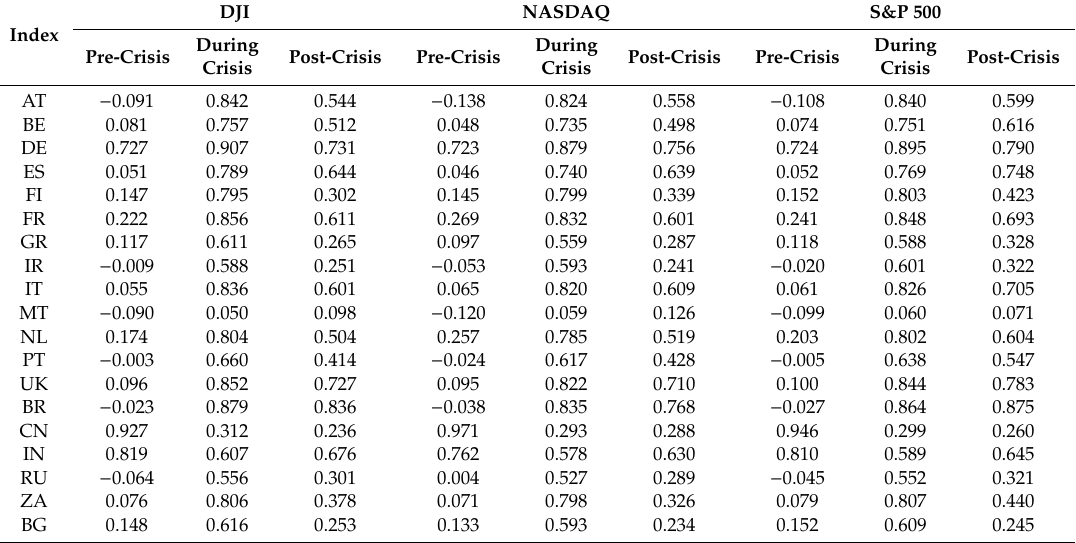
Cross correlations coe ffi cients between lag predicted series during Pre-GFC. GFC and